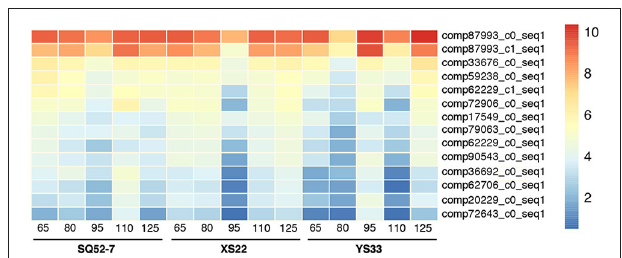
FIGURE 8 | Heatmap showing expression patterns of pyrophosphate-energized vacuolar membrane proton pump encoding unigenes. Normalized log2-transformed RPKM gene expression values were used to plot the heatmap.